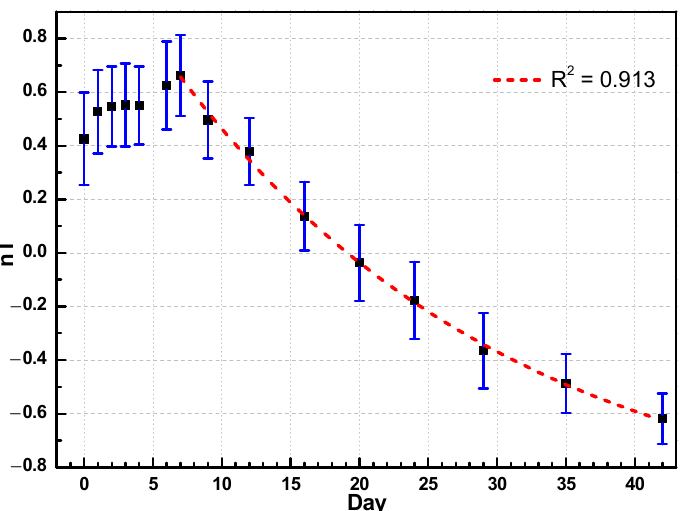
Figure 8. Evolution of the normalized transmittance spectrum, nT( λ 1 ), in the 590 nm band. nT( λ 1 ) changed slightly in the first week and then exponentially decayed. The value then dropped from 0.66 to −0.62 over five weeks.